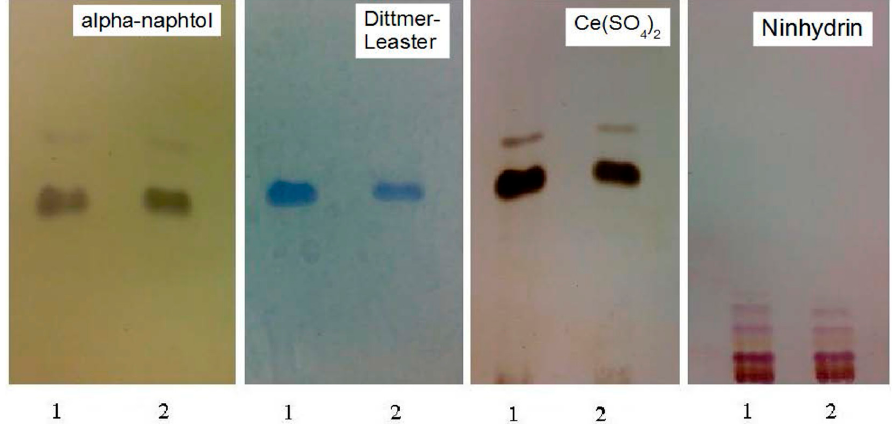
Figure 3. Thin layer chromatography (TLC) of polar lipids, extracted from freeze drying cells